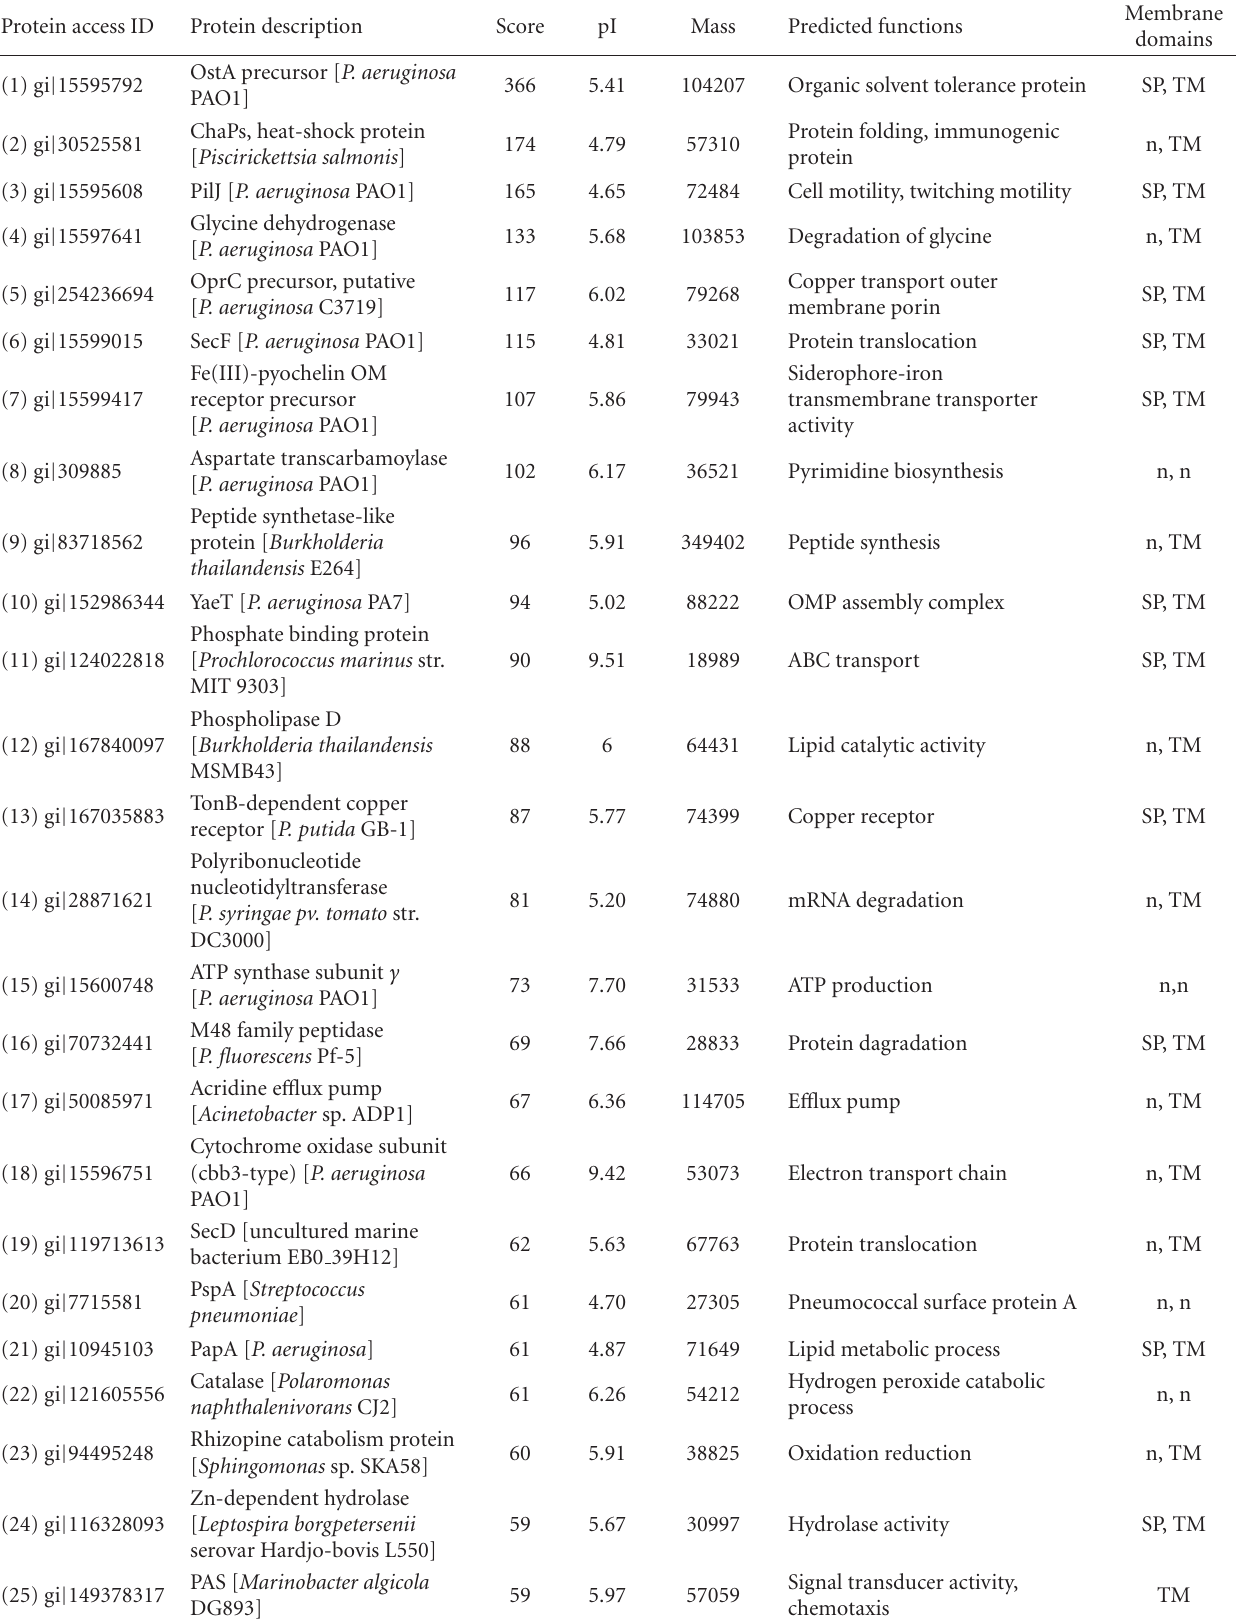
Table 1: The WT OMV proteins.